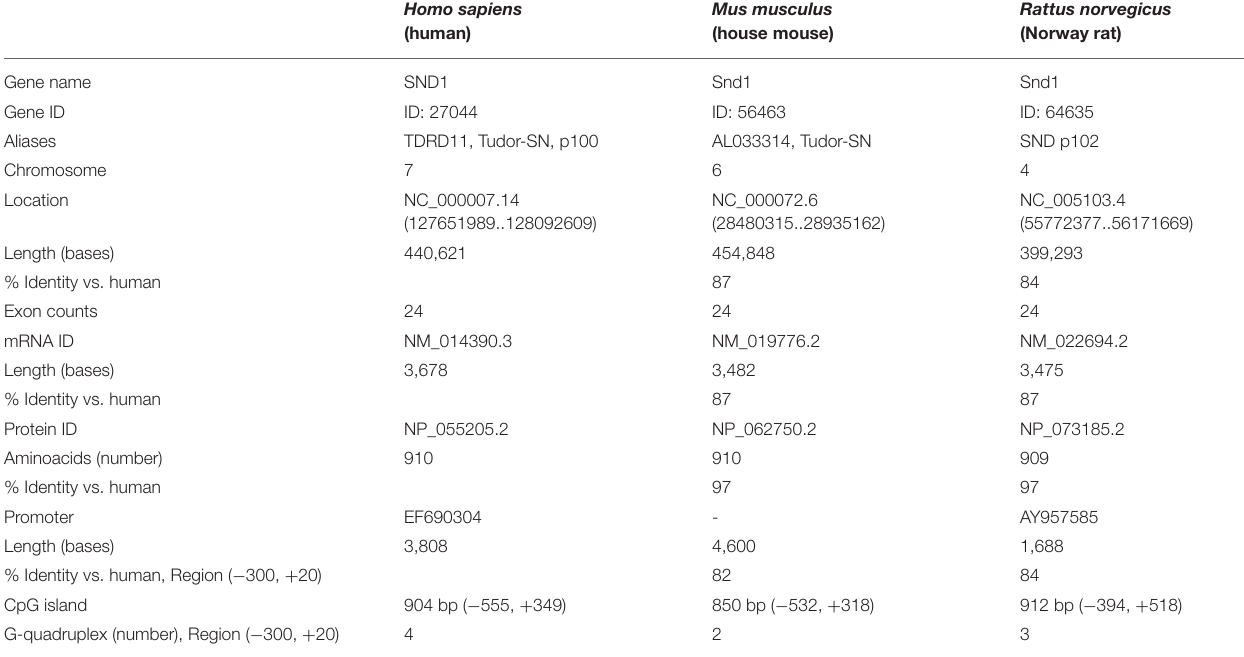
TABLE 1 | General information of SND1 gene, transcript, protein and promoter in humans, mouse and